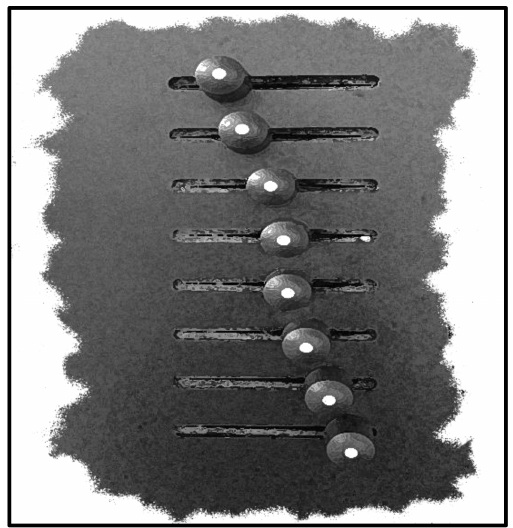
Figure 1. An example of correct doppler US set up with a gently curved